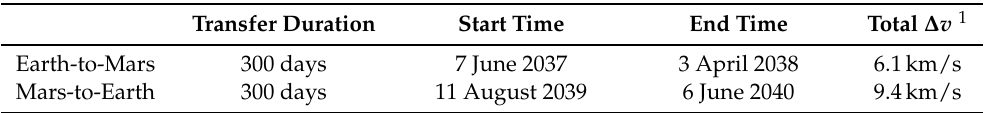
Table 3. Parameters for one optimal mission profile for manned Mars mission using electric propul- sion engines. Time of expedition: < 1000 days. The launch window is 2035–2050. Transfer Duration Start Time End Time Total ∆ v 1 Earth-to-Mars 300 days Mars-to-Earth 300